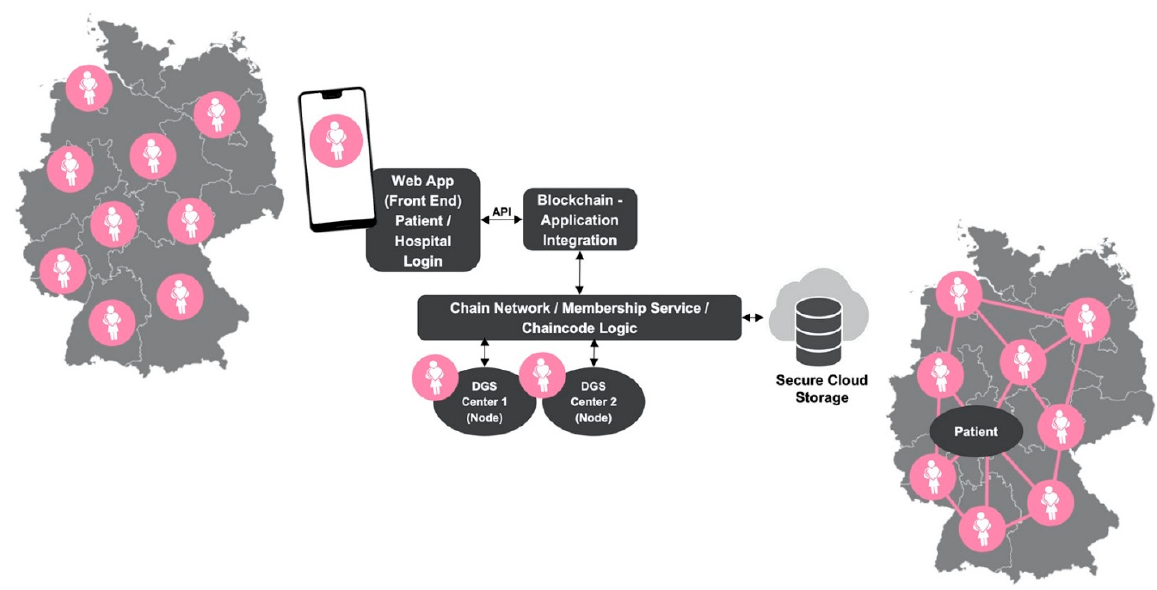
Figure 3. Overview of the technological solution (DGS = German senological center, API = application programming